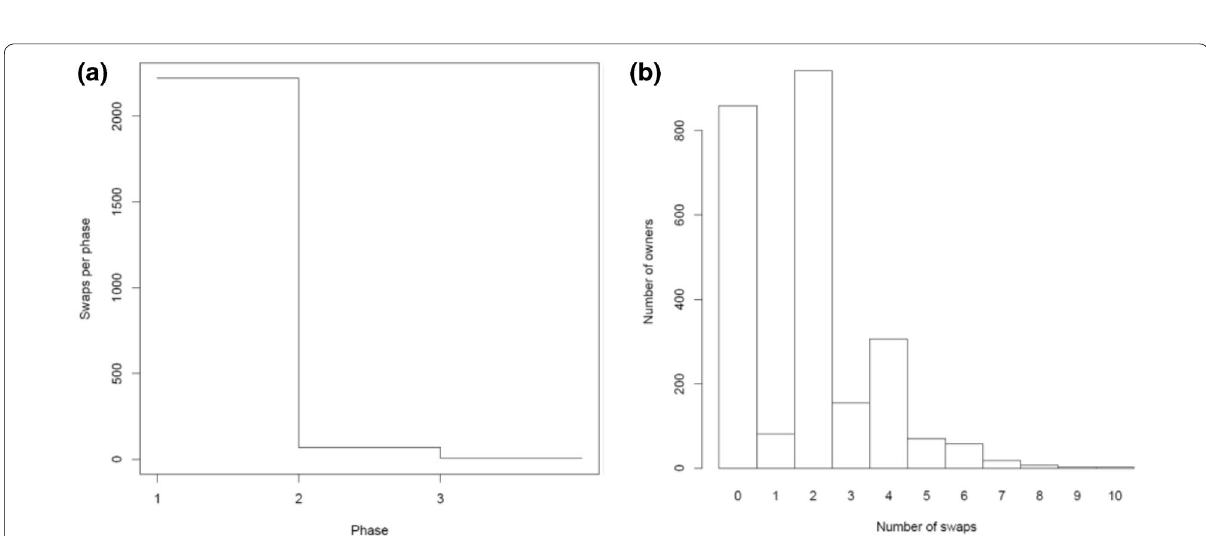
Fig. 5 Statistics of the run shown in Fig. 3. a Gives the number of parcel swaps per phase, and ( b ) shows the distribution of swaps per owner indicating that one may expect rather few swaps per